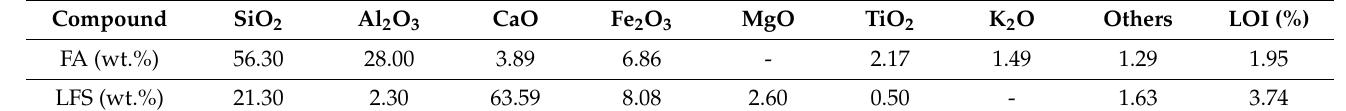
Table 1. Chemical composition and loss on ignition of fly ash and ladle furnace slag.